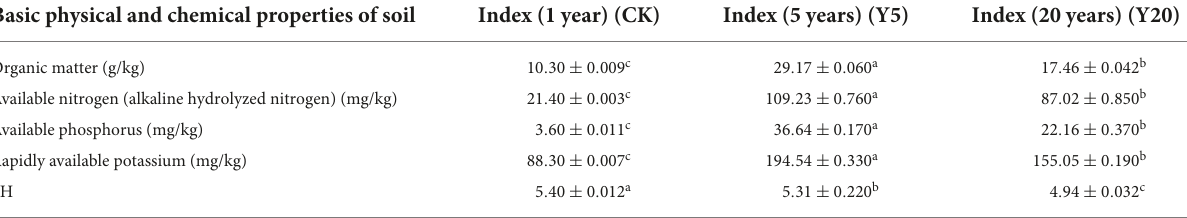
TABLE 1 Physicochemical properties of rhizosphere soil of M. integrifolia treatment groups (CK = 1-year monoculture orchard, Y5 = 5-year monoculture orchard, and Y20 = 20-year monoculture orchard). Basic physical and chemical properties of soil